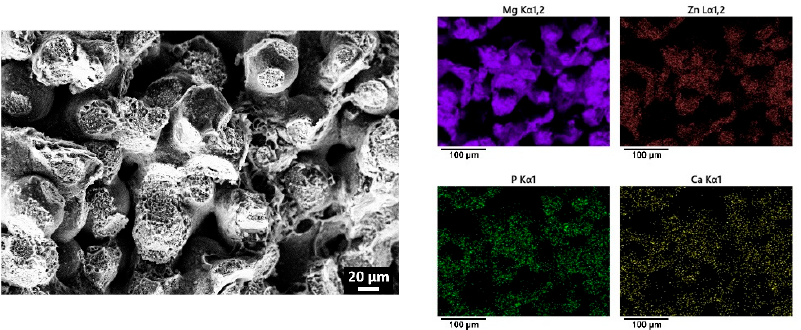
Figure 7. SEM and EDX images of the porous Mg-Zn-Zr scaffold’s fracture surface coated with hydroxyapatite.